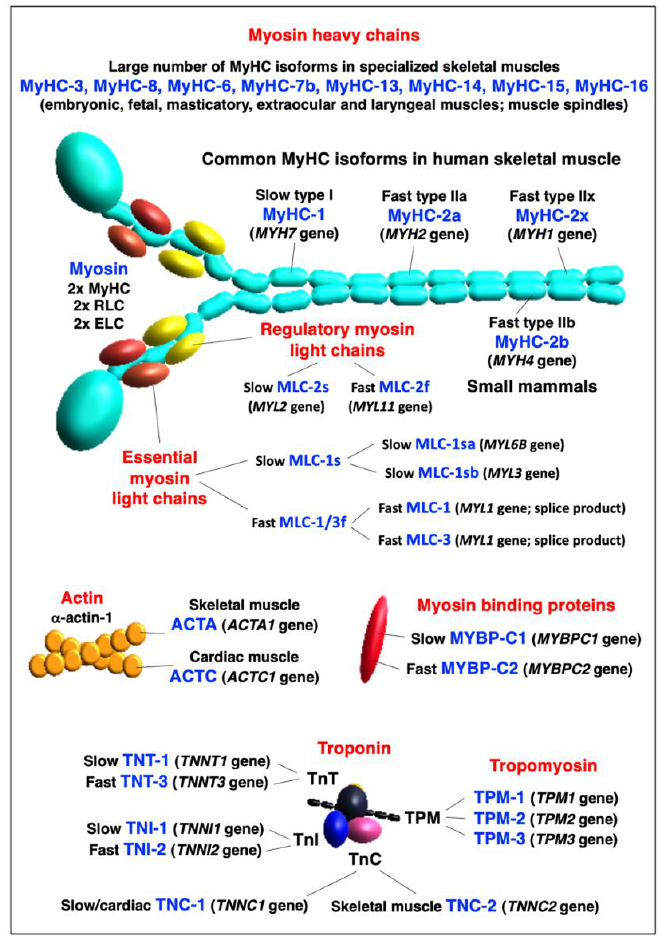
Figure 2. Summary of slow versus fast isoforms of key sarcomeric proteins. The diagrammatic presentation and color coding of individual contractile proteins is identical to the descriptions given in the overview of the sarcomeric structure and the contractile acto-myosin apparatus of skeletal muscle in Figure 1 above. Abbreviations used: ACT, actin; ELC, essential light chain; MYBP, myosin-binding protein; MyHC, myosin heavy chain; MLC, myosin light chain; RLC, regulatory light chain; TNC; troponin-C; TNI; troponin-I; TNT, troponin-T; TPM, tropomyosin.